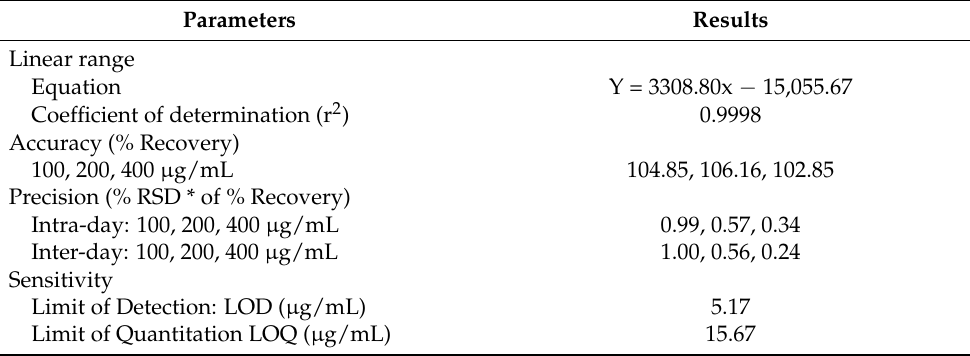
Figure 1. Chromatogram of ethanolic fenugreek extract using rutin as a chemical marker. Table 1. Parameters of method validation for Rutin detection based on AOAC guidelines.